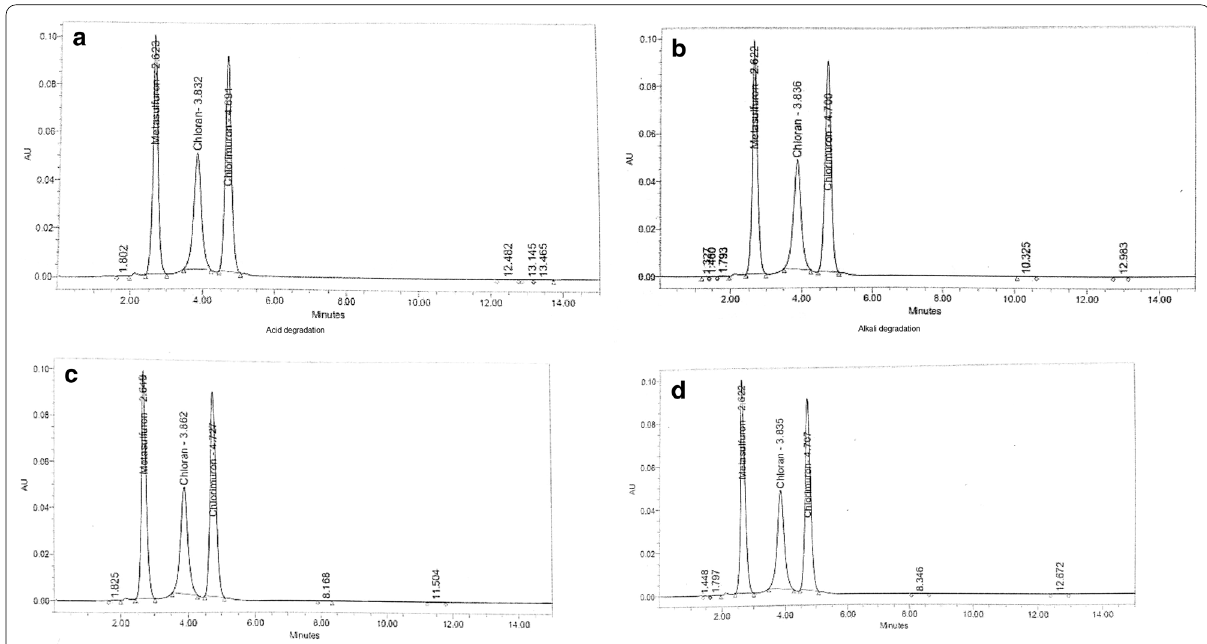
Fig. 9 Chromatograms of analytes after stress conditions of a acid degradation, b alkali degradation and c oxidative degradation and d reduction